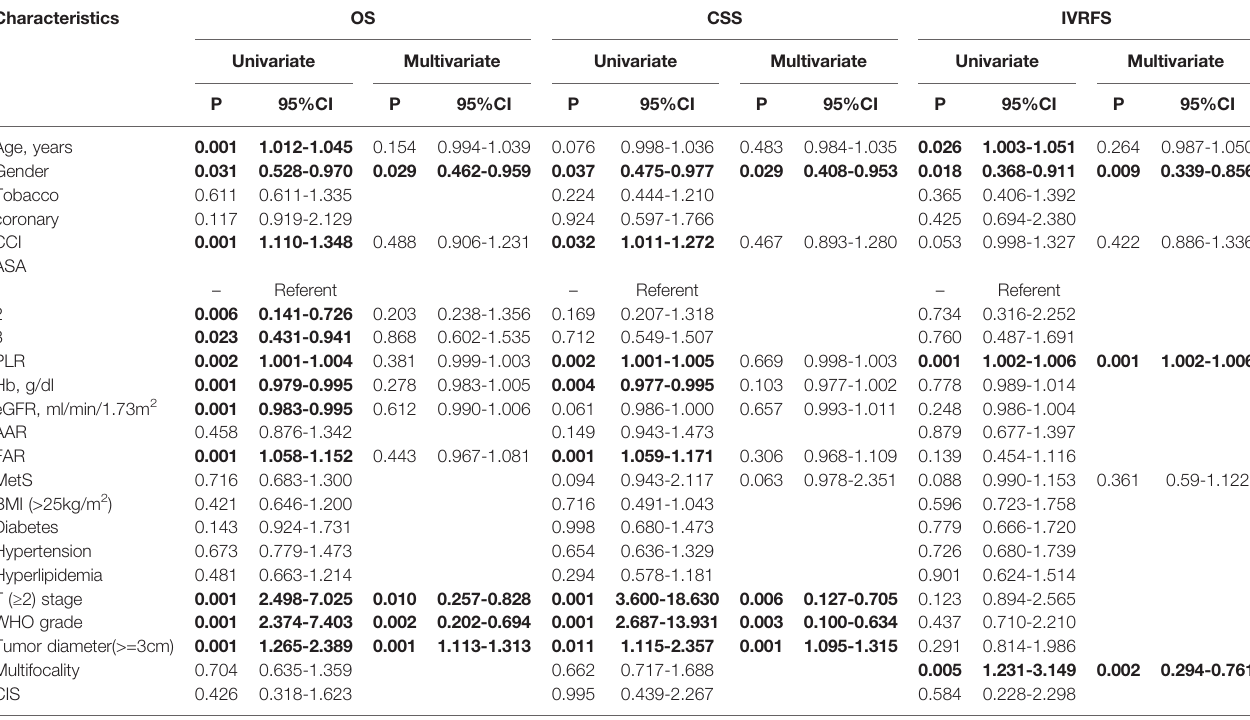
TABLE 2 | Univariate and multivariate cox regression analyses for OS, CSS and IVRFS before propensity score matching. Characteristics